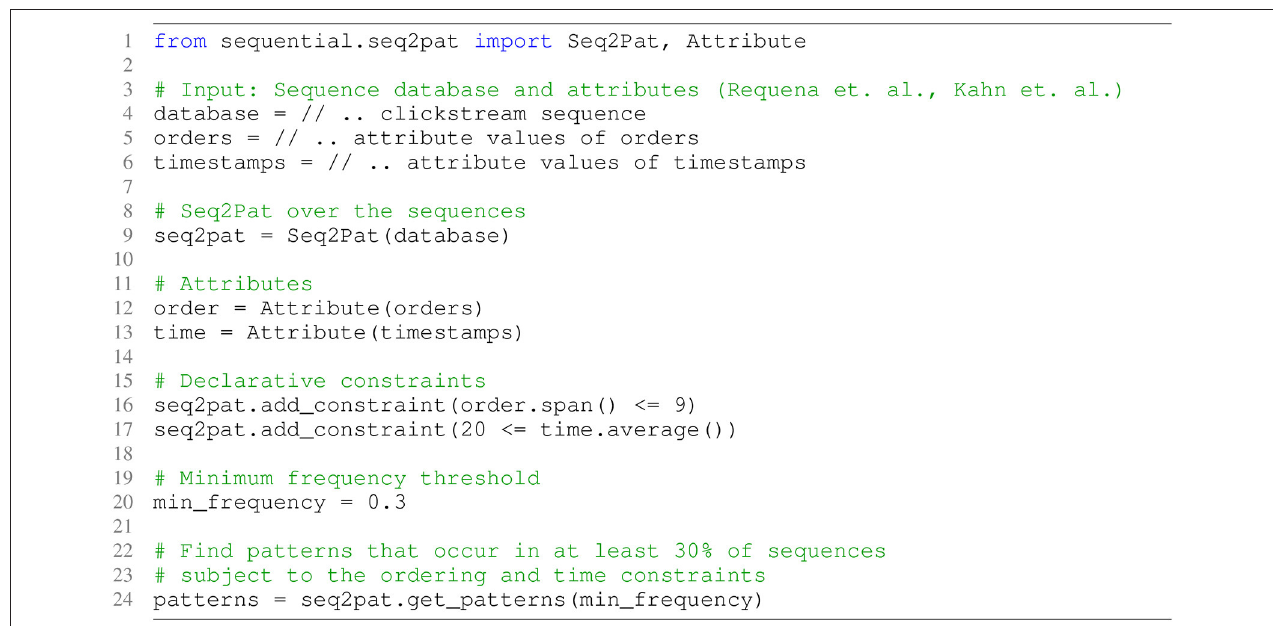
FIGURE 3 | Seq2Pat model to enforce sequential pattern mining with constraints on the clickstream dataset in fashion e-commerce.